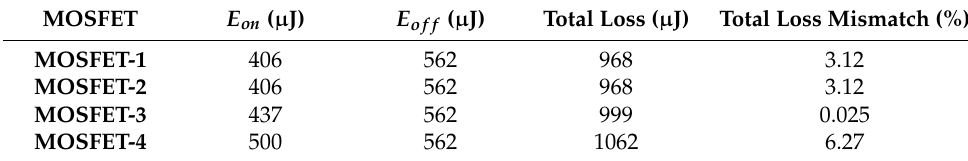
Figure 15. Paralleled SiC MOSFET currents. Table 7. Switching loss comparison.